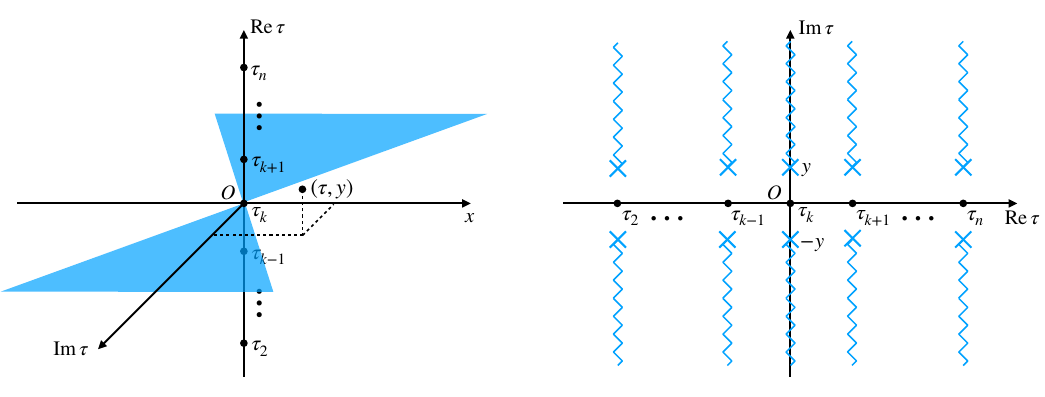
is illustrated in blue triangles. k